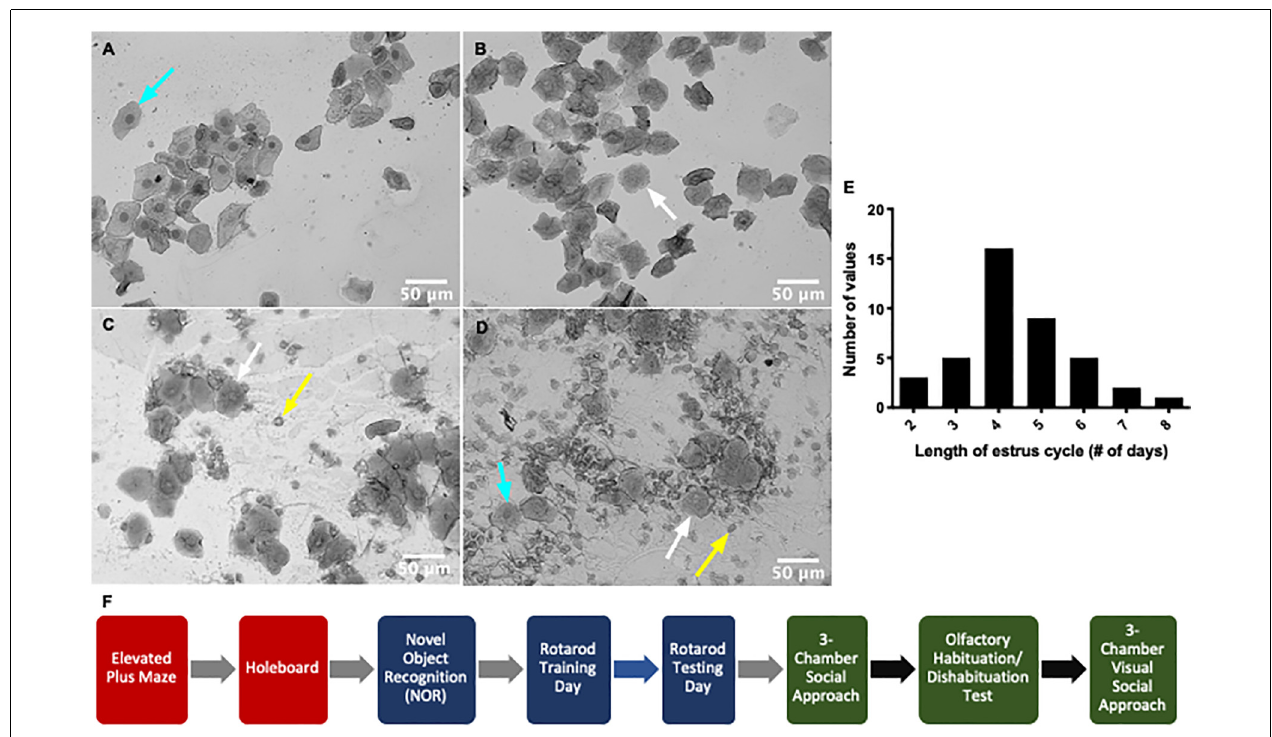
FIGURE 1 | Timeline of the mouse estrus cycle. The mouse estrus cycle occurs over 2–8 days as indicated by the histogram representing the length of estrus cycle for n = 41 female mice (E) and is represented by four distinct stages: proestrus (A) , estrus (B) , diestrus (C) and metestrus (D) . Each stage of the cycle is distinguished using vaginal cytology and identification of specific cell types (leukocytes—yellow arrow, nucleated epithelial cells—cyan arrow, cornified epithelial cells—white arrow). Mice in proestrus and estrus are sexually receptive (SR) and mice in diestrus and metestrus are non-receptive (NR). (F) The timeline of behavioral testing shows the order of behavioral tasks performed. Anxiety behavioral tasks (red) were first carried out to prevent any effect of handling on the behavioral output. This was followed by learning and memory tests (blue) and then sociability-related tests (green). Gray arrows indicate the subsequent behavioral task was carried out atleast 24 h to a week later. Black arrows signify the next task was carried out at least a week to 2 weeks later. Blue arrow denotes that rotarod testing was carried out 24 h after rotarod